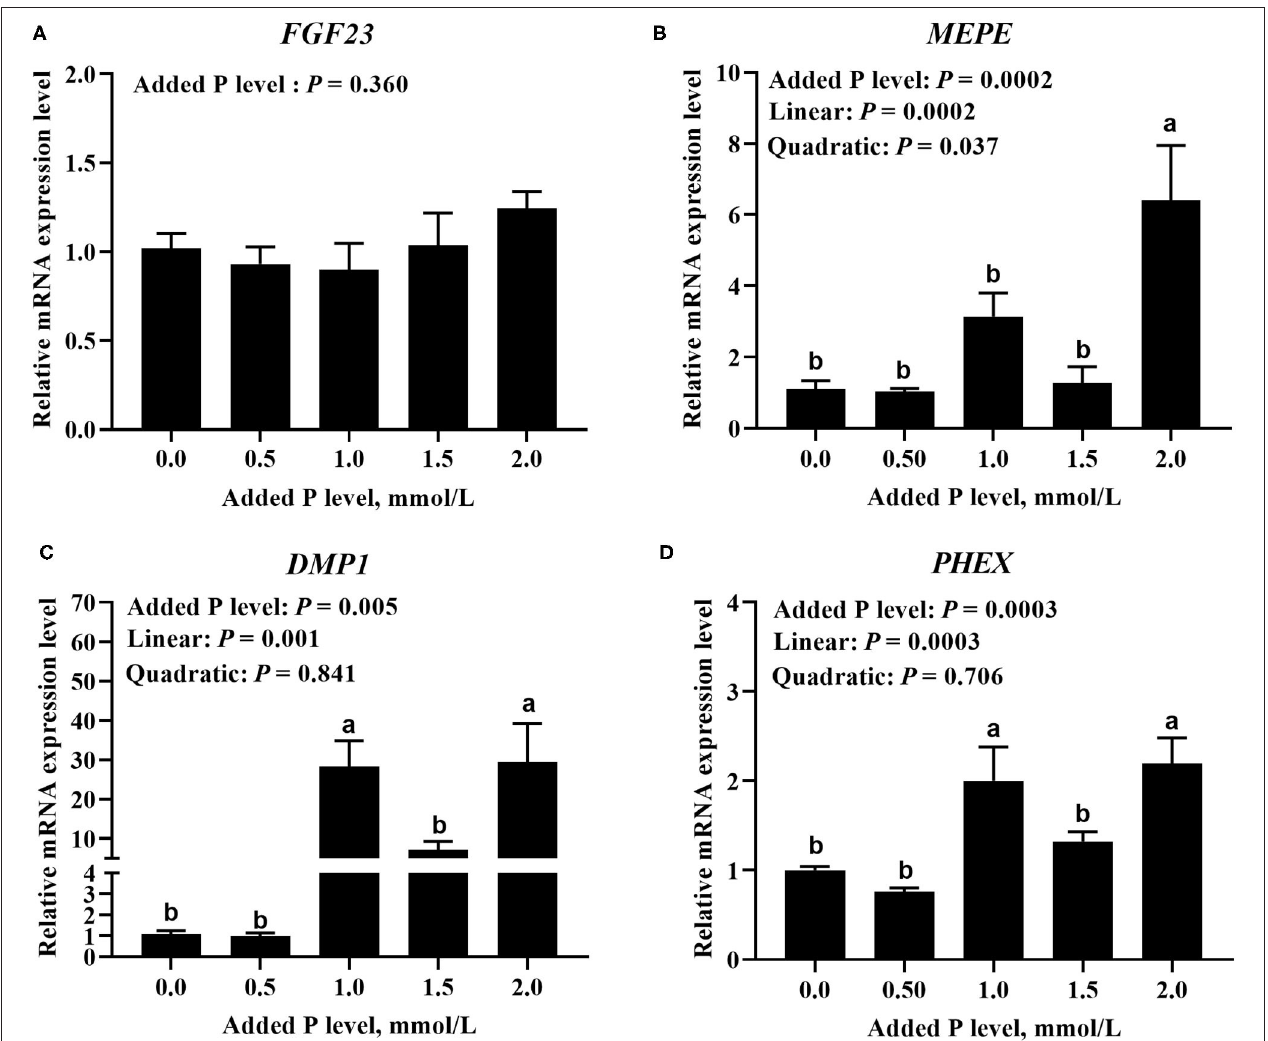
FIGURE 3 | Effect of added P level on the mRNA expression levels of FGF23 (A) , MEPE (B) , DMP1 (C) , and PHEX (D) in primary cultured tibial osteoblasts of broiler chicks. Each value was mean ± SE, n = 6. Means without a common letter differ, p ≤ 0.05. FGF23 , fibroblast growth factor 23; MEPE , matrix extracellular phosphoglycoprotein; DMP1 , dentin matrix protein 1; PHEX , phosphate-regulating gene homologous to endopeptidase on X